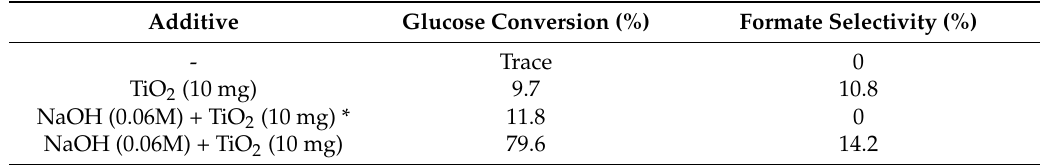
Table 7. Conversion of glucose and formate selectivity, reported by Jin et al. [46]. Additive Glucose Conversion (%) Formate Selectivity (%) -